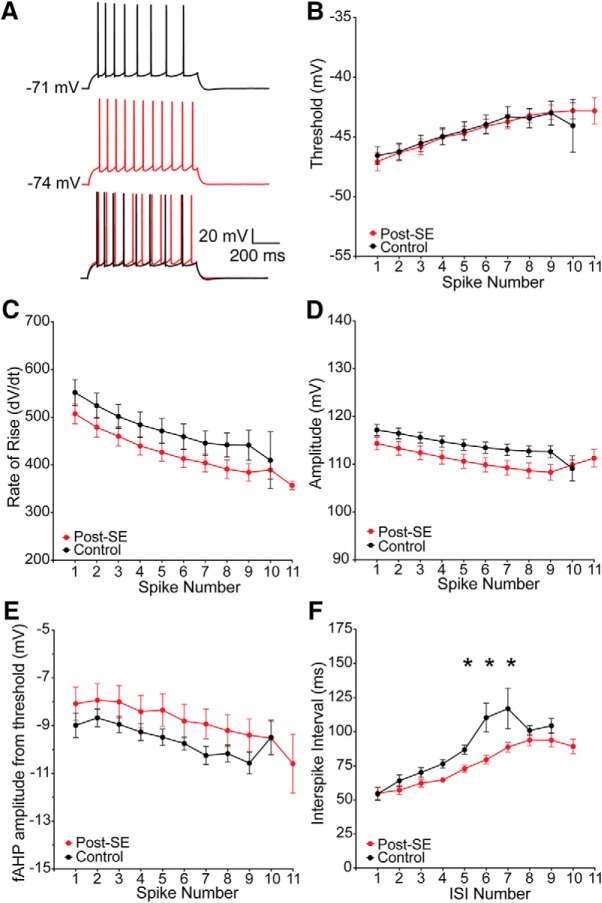
Reduced ISI contributes to increased firing in dorsal CA1 neurons post-SE. A, Representative trains of 8–11 action potentials from dorsal CA1 neurons from control and post-SE groups. Trains are evoked from the resting membrane potential with a variable amplitude current injection. The traces are overlaid at the bottom, which allows for direct comparison of trace features. B, Threshold, plotted as a function of spike number in the train, progressively increases, but was not different between the two groups. C, Maximum rate of rise was also not different between the two groups. D, Action potential amplitude was also not different between the two groups. E, The amplitude of the fAHP immediately following repolarization was also measured. The amplitude was not different between the control and post-SE dorsal neurons. F, ISI was measured between each action potential. Control dorsal neurons had a characteristic delay in the middle of the train, which was absent post-SE. *p < 0.05.